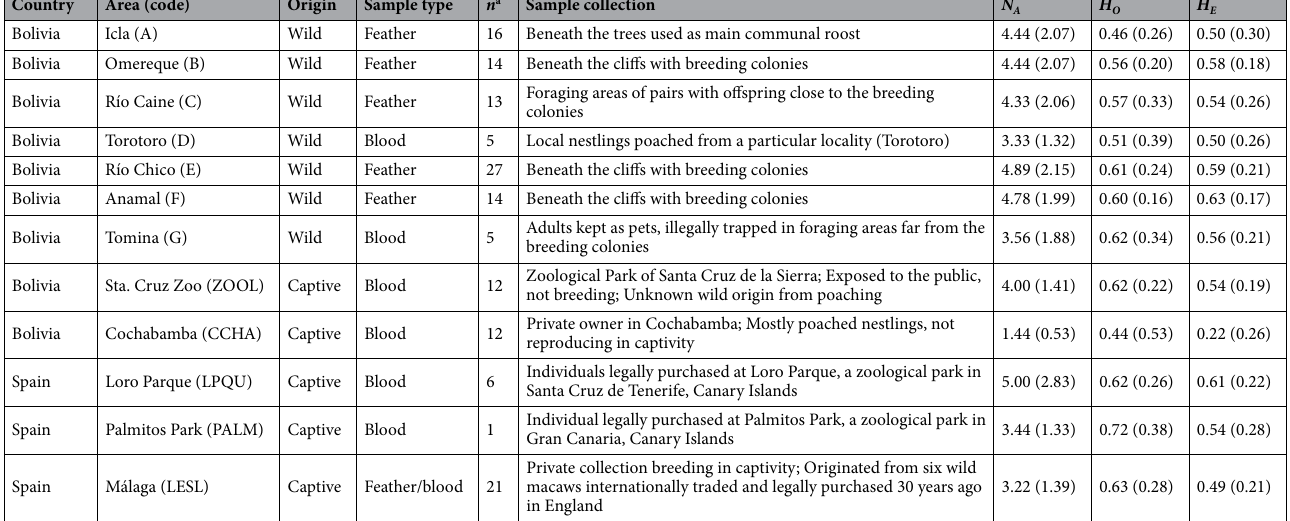
Individuals legally purchased at Loro Parque, a zoological park in Santa Cruz de Tenerife, Canary Islands Palmitos Park (PALM) Captive Blood 1 Individual legally purchased at Palmitos Park, a zoological park in Gran Canaria, Canary Islands Private collection breeding in captivity; Originated from six wild Captive Feather/blood 21 macaws internationally traded and legally purchased 30 years Table 3. Sampling characterisation, circumstances around sample collection and microsatellite genetic diversity indices for all localities. N A number of alleles, H O observed heterozygosity, H E expected heterozygosity. a Number of samples included in the final data set considering only one sample per individual and the missing data threshold.